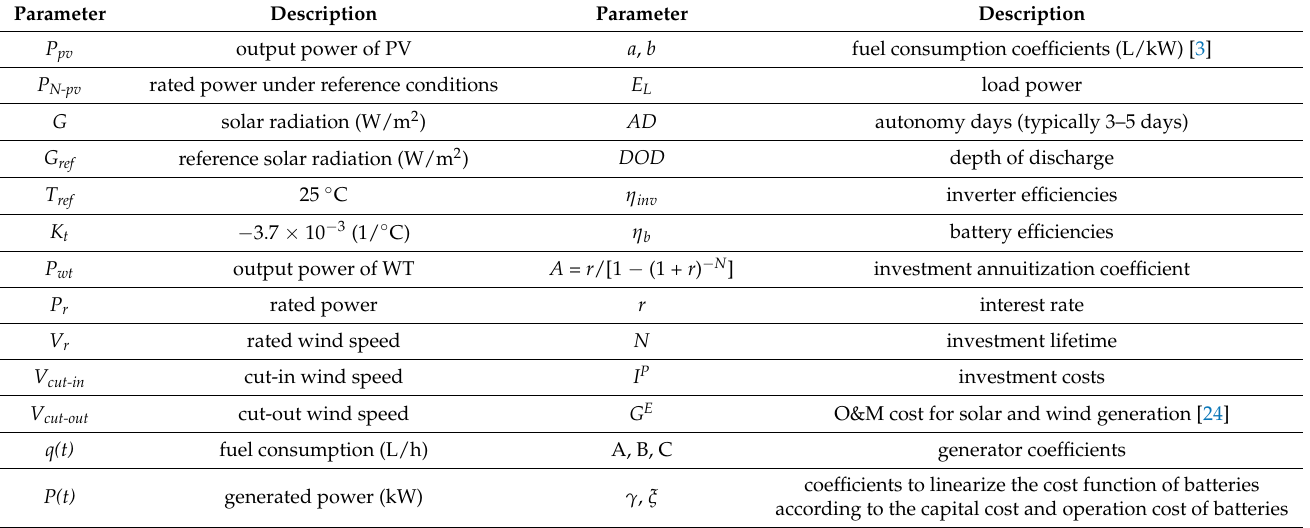
Table 2. Parameter definitions in Table